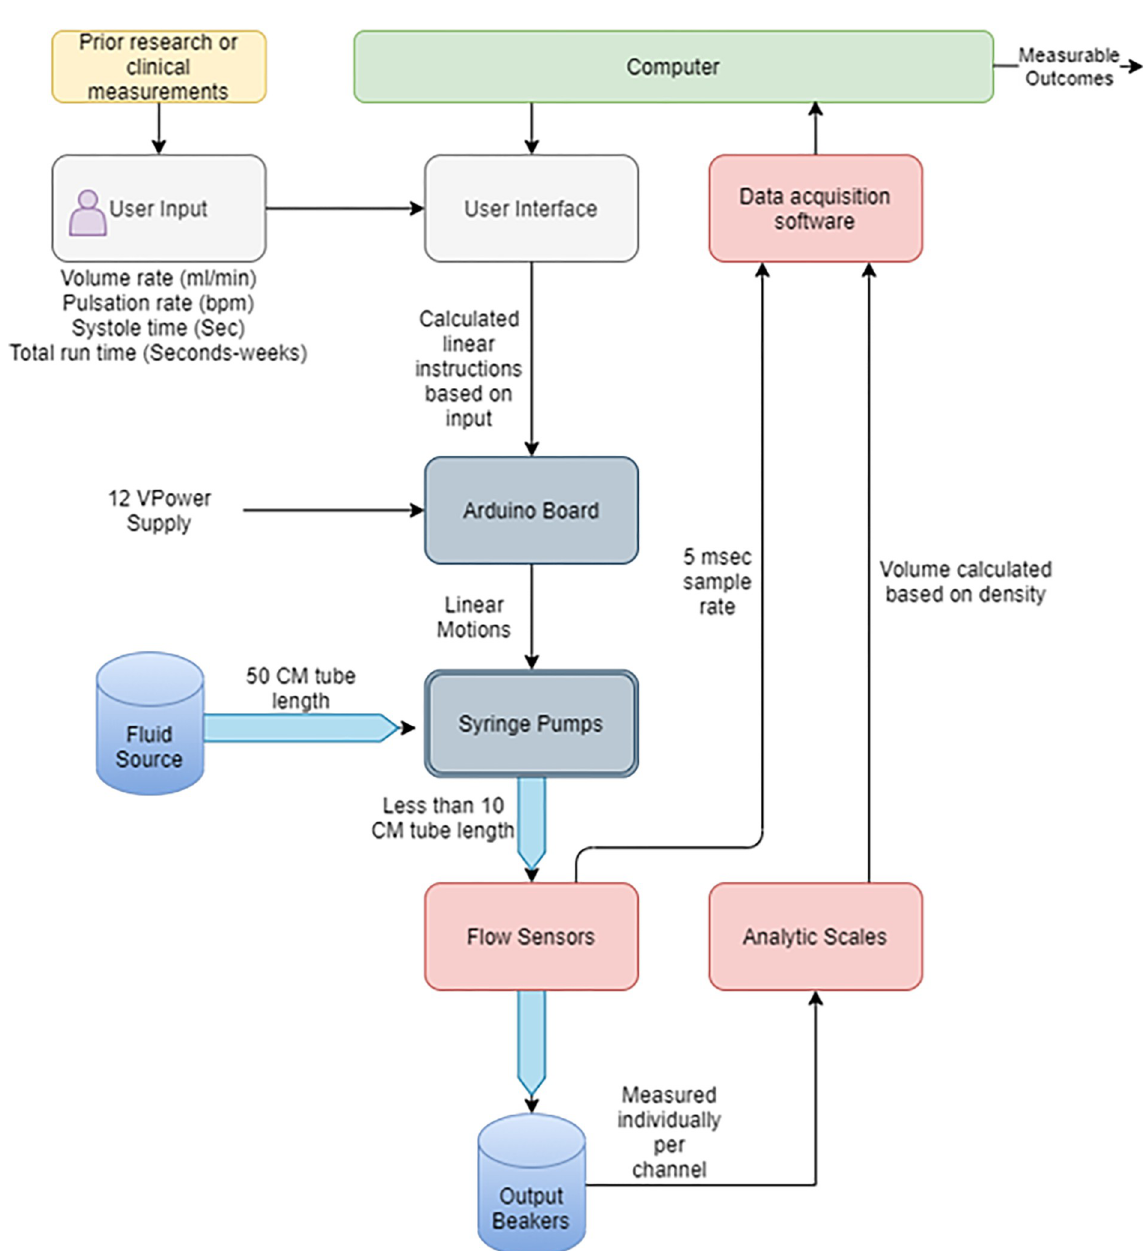
Fig 2. The overview diagram. Schematic diagram illustrating the flow of information and fluids from user input to analyzed measurable outcomes.